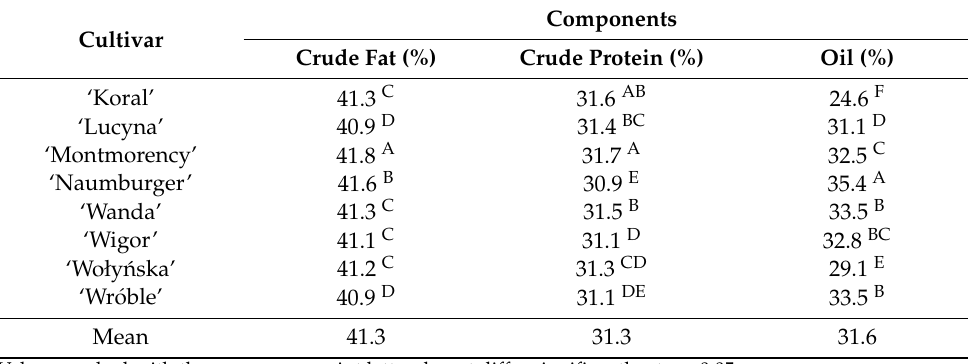
Table 1. The main components of sour cherry kernels of eight cultivars.